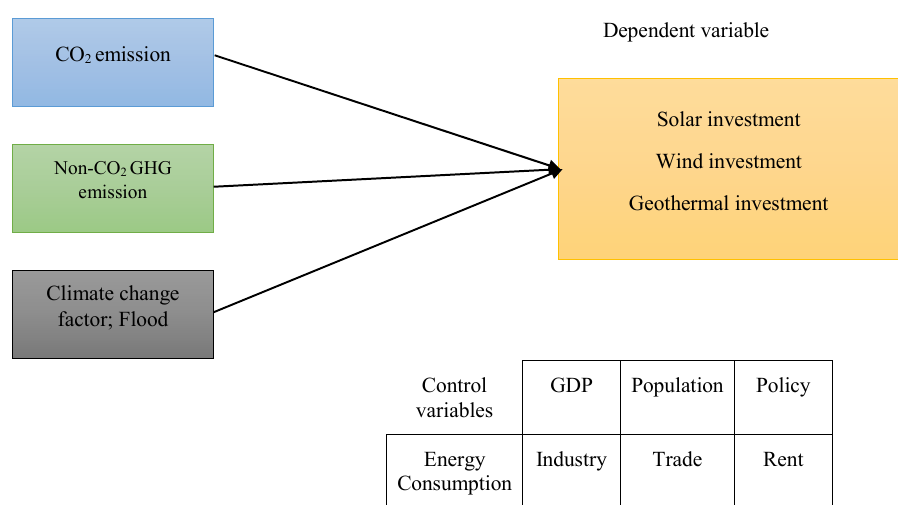
Figure 5. Model for panel regression.